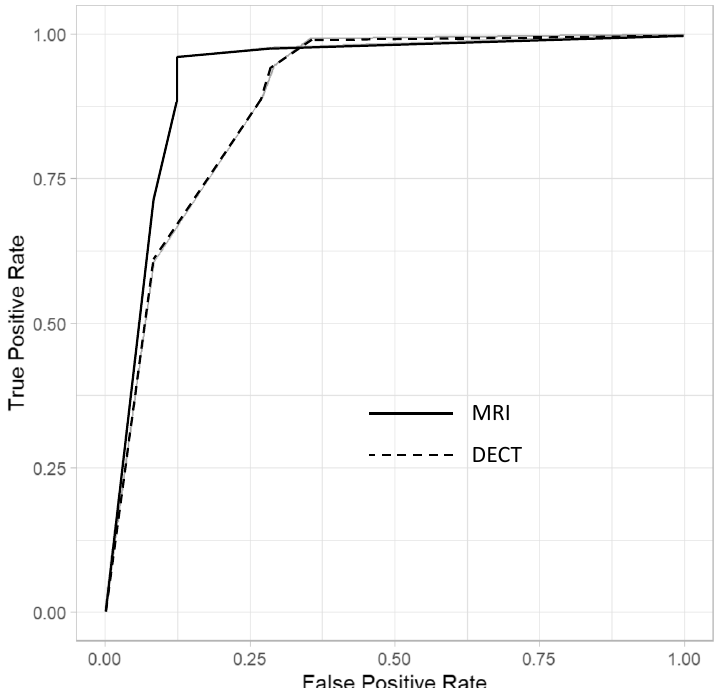
Figure 2. Diagnostic performance of the multi-reader multi-case analysis across all imaging modal- ities for MRI and DECT. The dashed line-curve represents DECT and the continuous line-curve represents MRI.